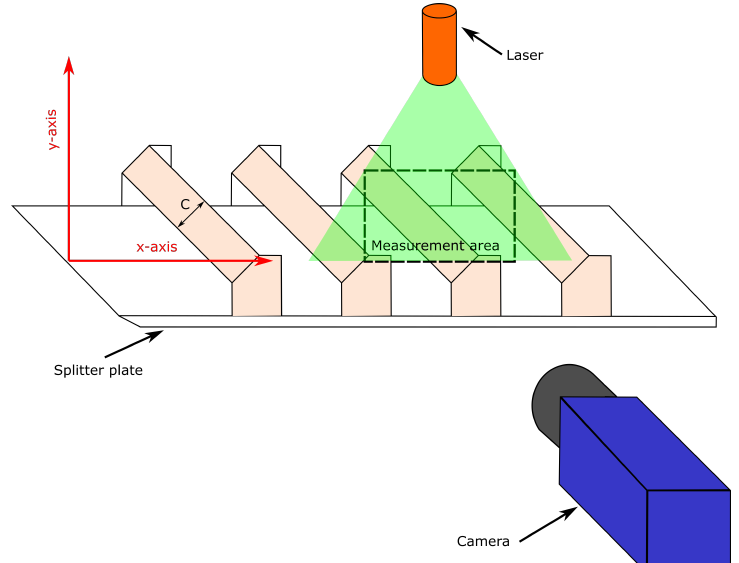
Figure 1. Sketch of the experimental setup. The streamwise and vertical direction are indicated as x and y ,